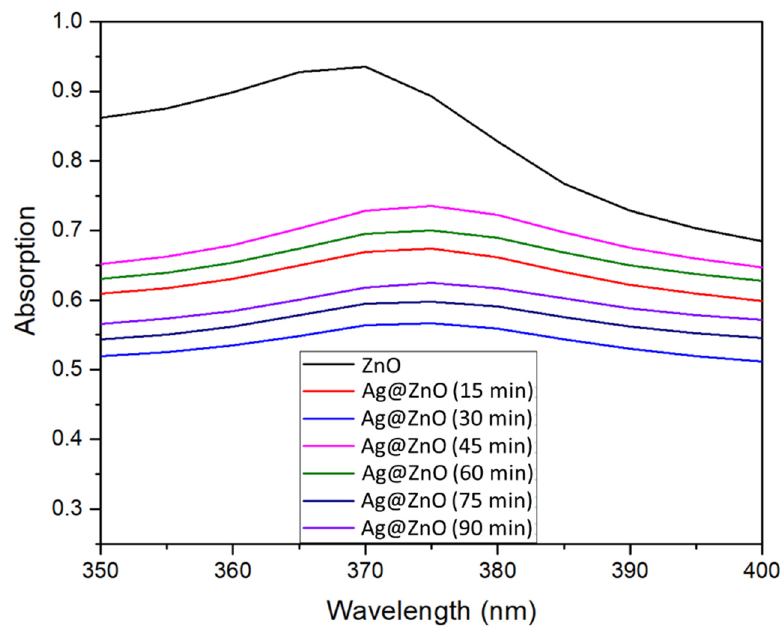
Figure 4. UV-Vis spectra of ZnO and Ag@ZnO at various irradiation times.